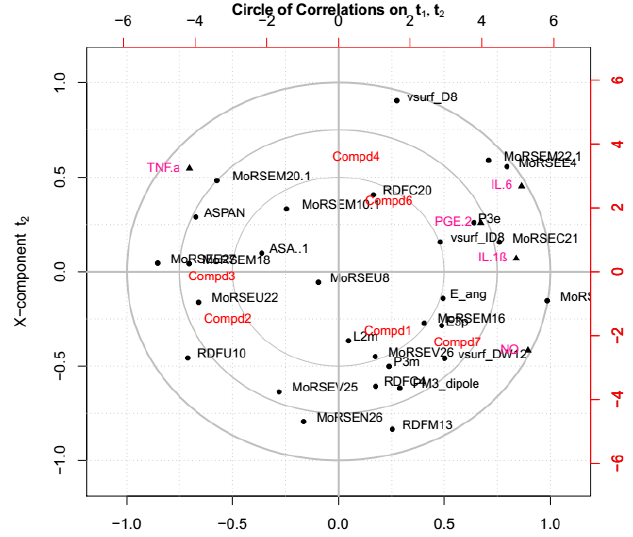
Figure 8. Principal component analysis (PCA) on relationship between inflammatory factors and calculated molecular descriptors presented by correlation circle.